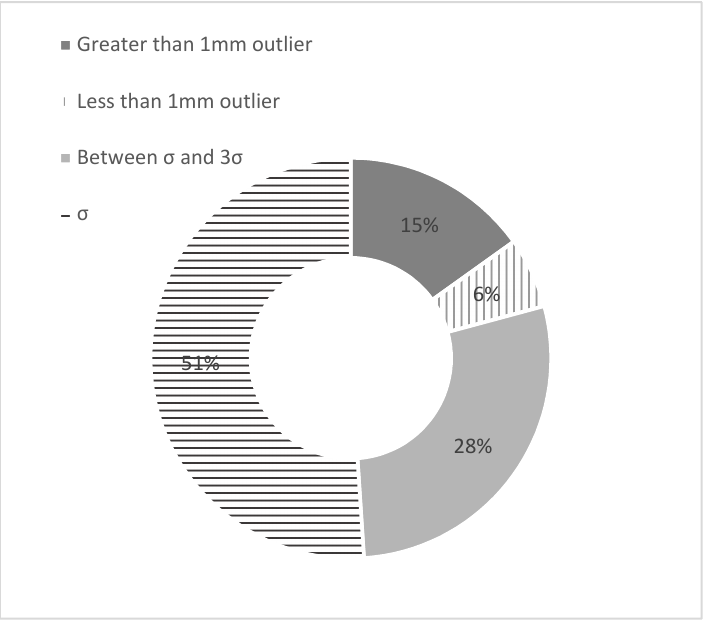
Figure 7. Percentage breakdown of the outliers.